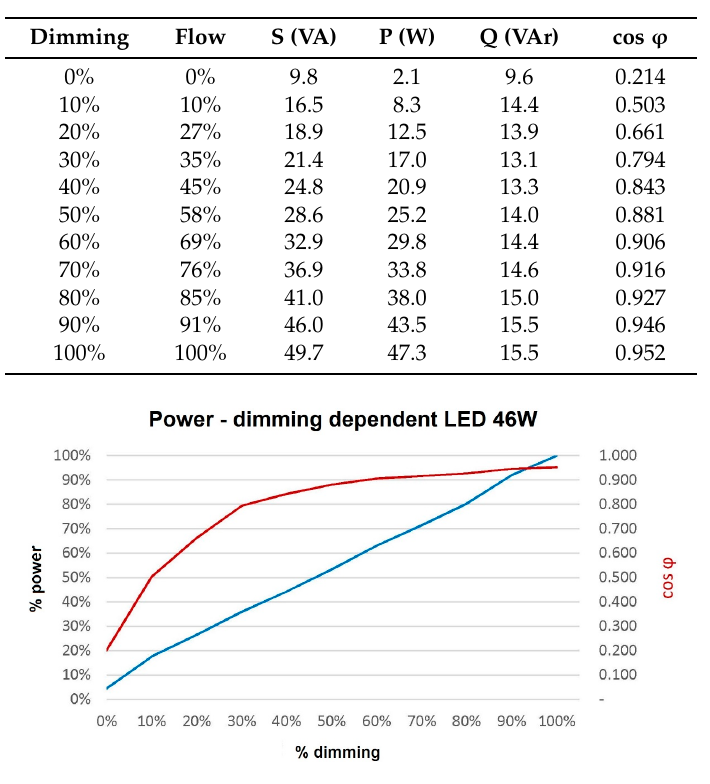
Table 1. Consumption and illuminance values at three checkpoints after programming.